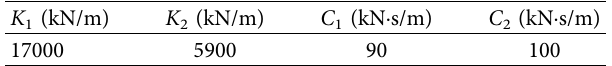
Table 2: Parameters of the spring-damping units.